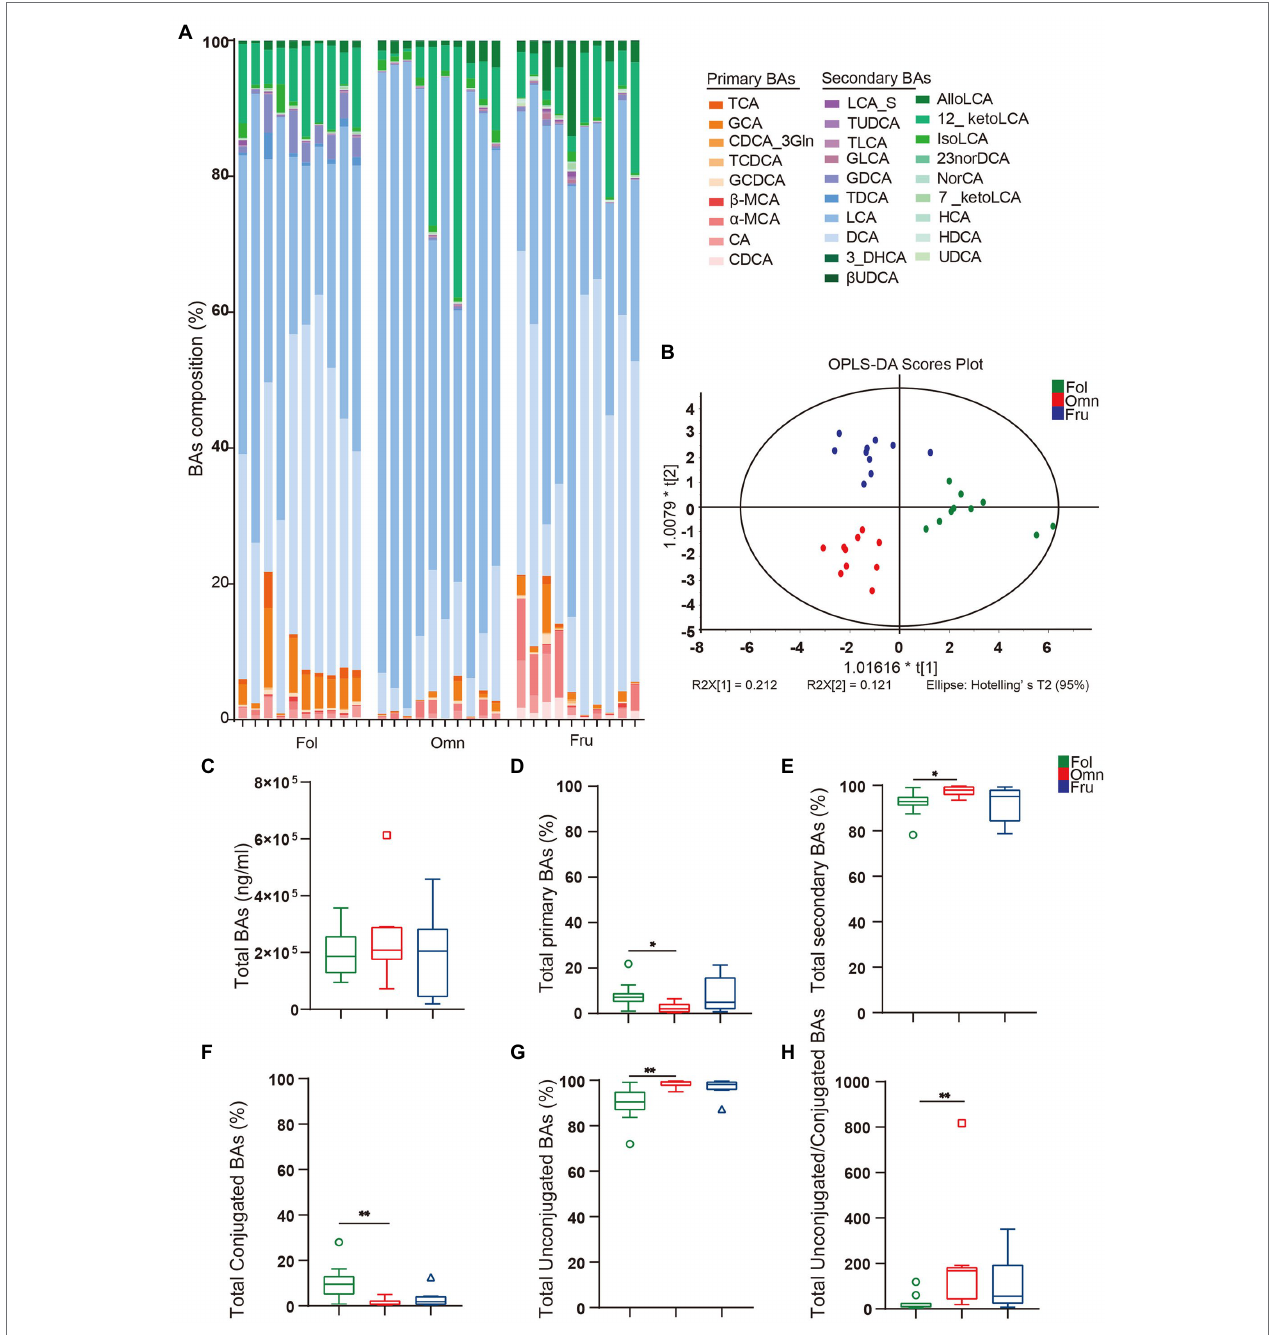
FIGURE 2 | BAs metabolome. (A) BAs composition column. (CA, cholic acid; GCA, glycocholic acid hydrate; TCA, taurocholic acid; CDCA, chenodeoxycholic acid; GCDCA, glycochenodeoxycholic acid sodium salt; CDCA_3Gln, chenodeoxycholic acid-3- β -D-glucuronide; TCDCA, taurochenodeoxycholic acid sodium salt; DCA, deoxycholic acid; GDCA, glycodeoxycholic acid; TDCA, taurodeoxycholic acid sodium salt; UDCA, ursodeoxycholic acid; GUDCA, glycoursodeoxycholic acid; TUDCA, tauroursodeoxycholic acid dihydrate; β UDCA, 3 β -ursodeoxycholic acid; LCA, lithocholic acid; TLCA, taurolithocholic acid sodium salt; GLCA, glycolithocholic acid; LCA_S, lithocholic acid 3-sulfate sodium salt; HCA, hyocholic acid; HDCA, hyodeoxycholic acid; 7_ketoLCA, 7-ketolithocholic acid; NorCA, nor cholic acid; 23norDCA, 23-nordeoxycholic acid; isoLCA, isolithocholic acid; 12_ketoLCA, 12-ketolithocholic acid; AlloLCA, allolithocholic acid; 3_DHCA, 3-dehydrocholic acid; α -MCA, alpha-muricholic acid; and β -MCA, beta-muricholic acid). (B) Orthogonal to partial least squares-discriminate analysis (OPLS-DA) score plots of fecal samples from the three primate dietary groups. (C) Total bile acids (BAs) levels. (D) Total primary BAs (%). (E) Total secondary BAs (%). (F) Total conjugated BAs (%). (G) Total unconjugated BAs (%). (H) The ratio of conjugated/unconjugated BAs. A value of p < 0.05 was considered statistically significant. * p < 0.05; ** p < 0.01. All data are shown in box-and-whisker plots according to